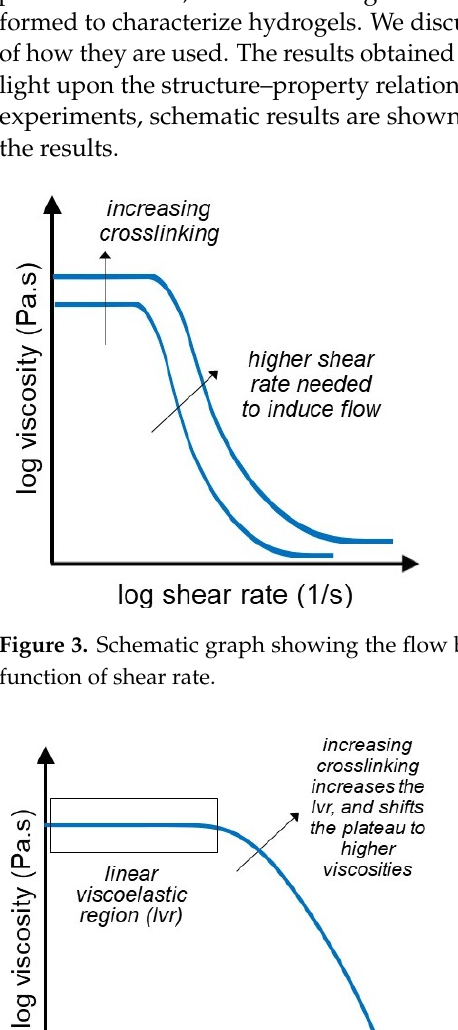
Figure 5. Time sweep experiment shows the formation of the network structure of the hydrogel over time. The crossover point of G’ and G” indicated the gelation point.